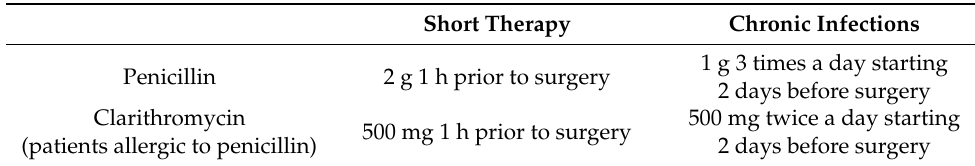
Table 3. Prophylactic antibiotic